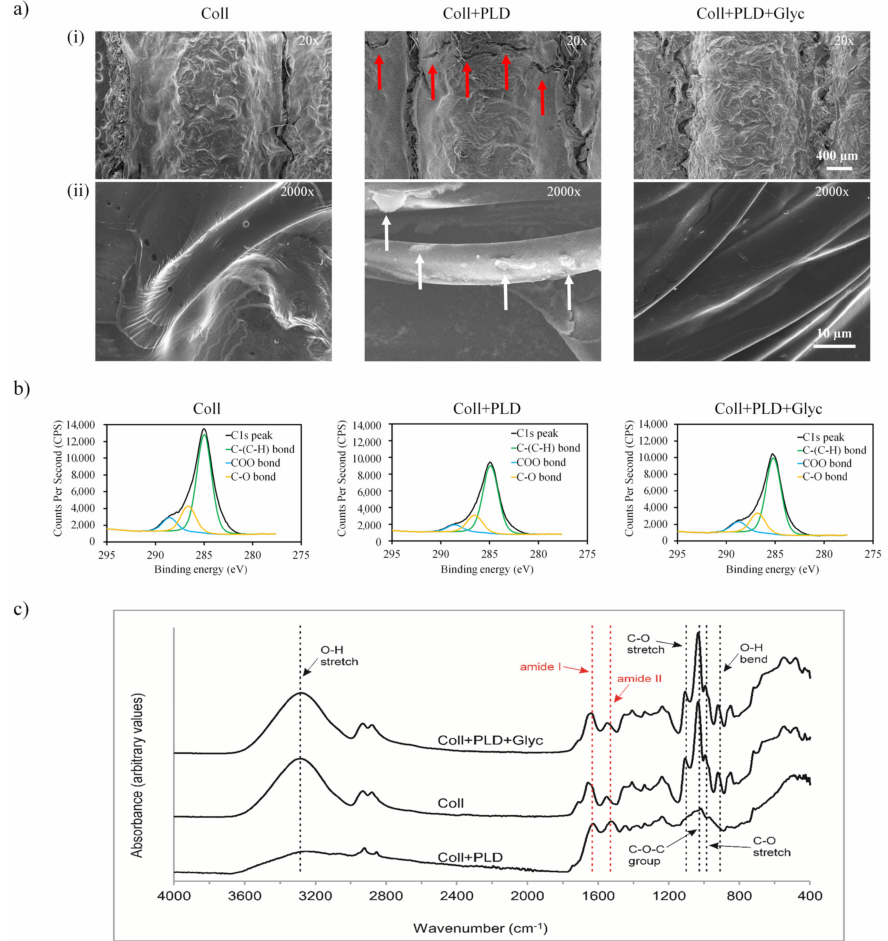
Figure 1. ( a ) SEM micrographs of Coll, Coll+PLD and Coll+PLD+Glyc vascular grafts at ( i ) 20 × magnification and ( ii ) 2000 × magnification. Scale bars: 400 µ m and 10 µ m. ( b ) XPS C1s peak deconvolution showing the peaks corresponding to C–(C/H), C–O and COO bonds of Coll, Coll+PLD and Coll+PLD+Glyc samples. ( c ) ATR-FTIR spectrum of Coll, Coll+PLD and Coll+PLD+Glyc grafts. Glycerol-related bands were marked in black and collagen-related bands were marked in